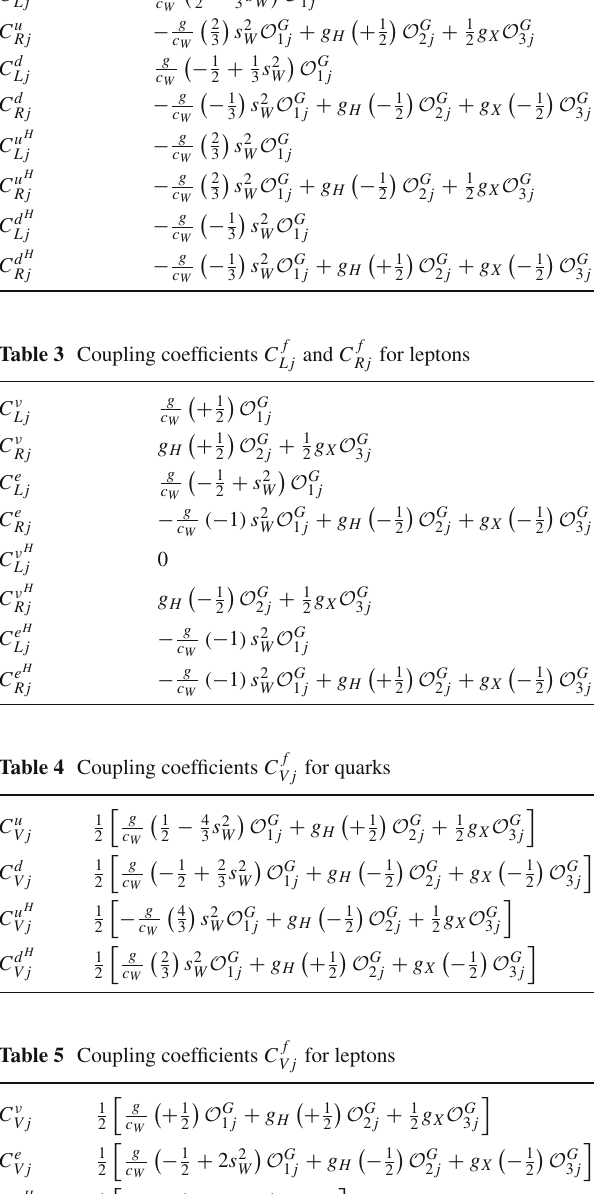
Table 2 Coupling coefficients C f